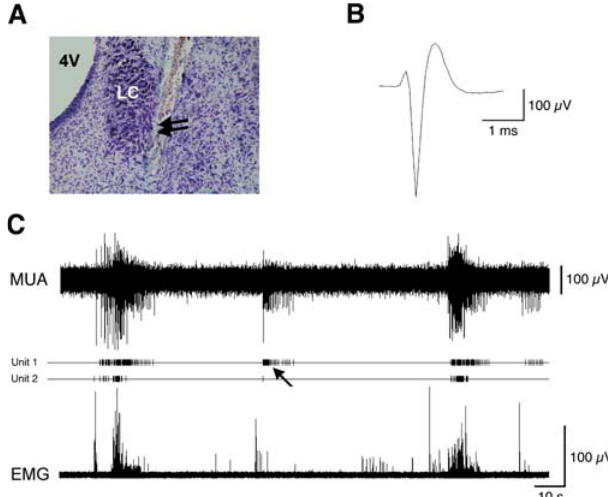
Figure 6. Activity of LC Neurons across the Sleep-Wake Cycle in a P8 Rat (A) Coronal section of the LC indicating the recording site (double arrows). (B) Averaged waveform of unit 2 in (C). (C) Upper trace: LC multiunit activity. Middle traces: Activity of two isolated units derived from the multiunit activity. Bottom trace: concurrently recorded nuchal EMG. 4V, fourth ventricle; LC, locus coeruleus DOI: rates (5.67 6 1.49 Hz during atonia and 11.10 6 2.22 Hz